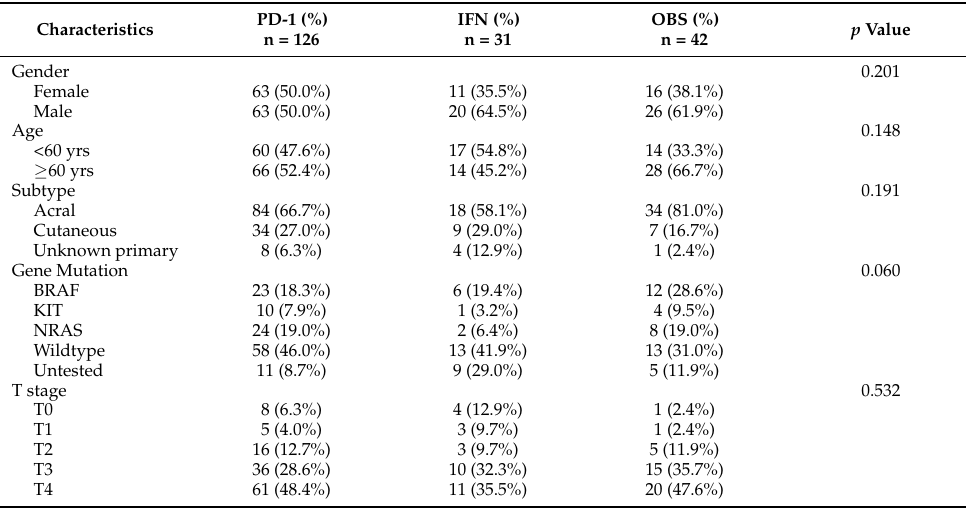
Table 1. Demographics and clinicopathologic characteristics of the